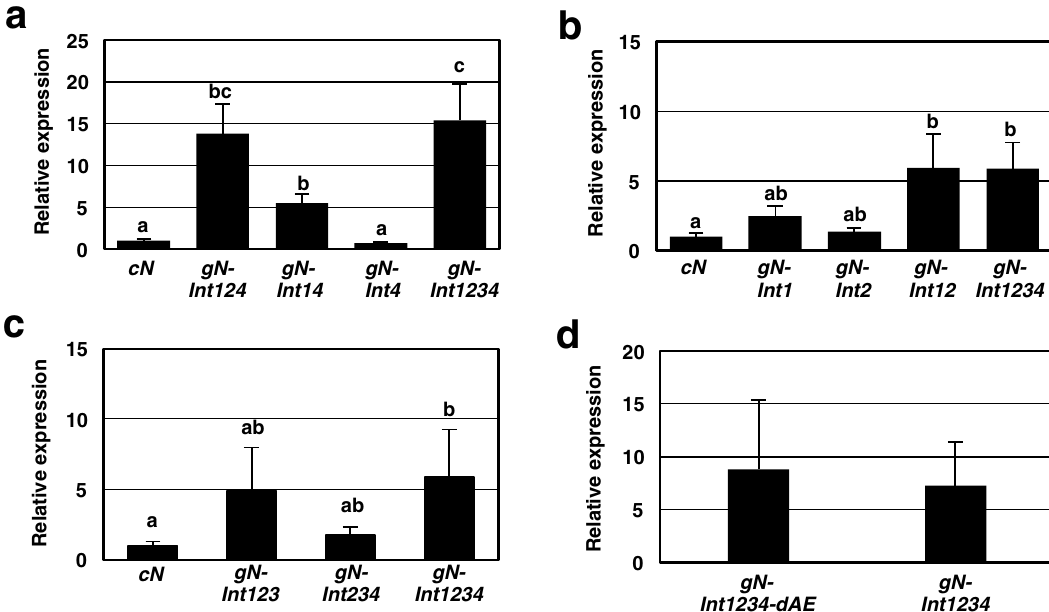
Figure 3. Involvement of introns 1 and 2 in the enhanced expression of the 35S-driven N transgene. ( a – d ) Agrobacterium transformants carrying a plasmid for the indicated N transgene were infiltrated to nn tobacco. The levels of N transcript were analyzed by RT-qPCR with F1 + R1 primer set at 36 h post-infiltration (hpi). The transcript levels of cN were adjusted to 1 with levels for other treatments relative to these values. The transcript levels of actin were used for normalization of all values. Values are the means ± SE of three independent biological replicates. Data in ( a – c ) were analyzed by the two-way ANOVA test followed by the Tukey–Kramer test (p < 0.05). Different letters above the bars indicate the means are significantly different from each other at the 0.05 level. Absence of letters above bars in ( d ) indicates no significant difference between